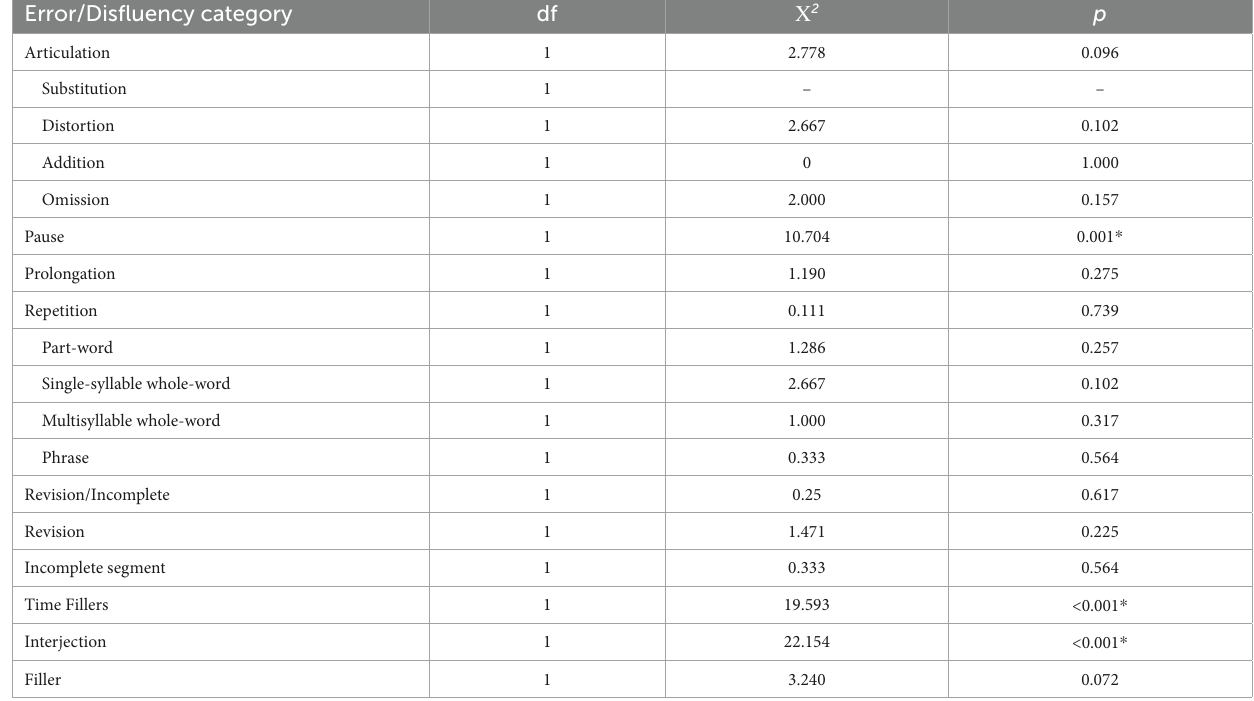
TABLE 3 Results of Friedman tests of speech error/disfluency rates at the α = 0.05 level for baseline compared to concussion. Error/Disfluency